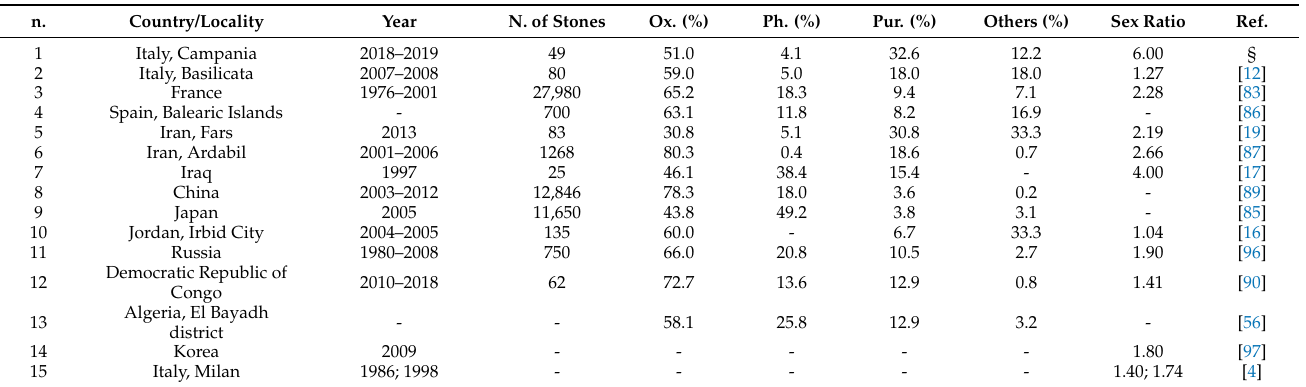
Table 3. Frequency of the compositional distribution of urinary stones in patients from the Campanian region compared to literature data. Sex ratios (male-to-female) have also been reported. Note: Ox., oxalate stones; Ph., phosphate stones; Pur., purine stones; §, present